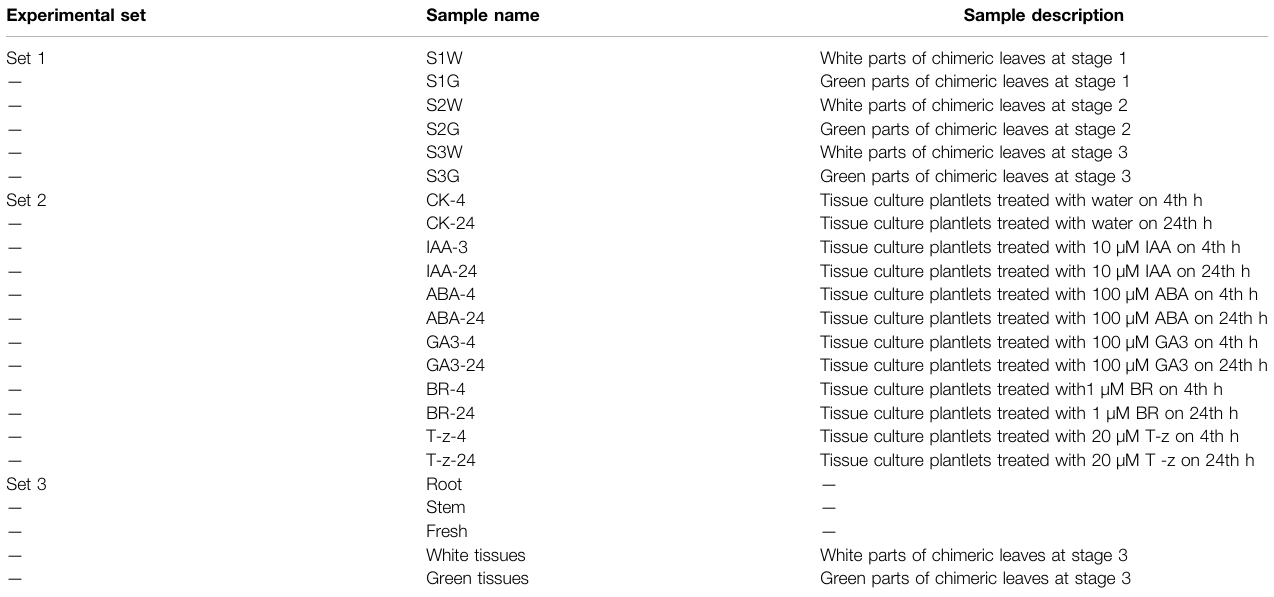
TABLE 1 | Samples used in this study.